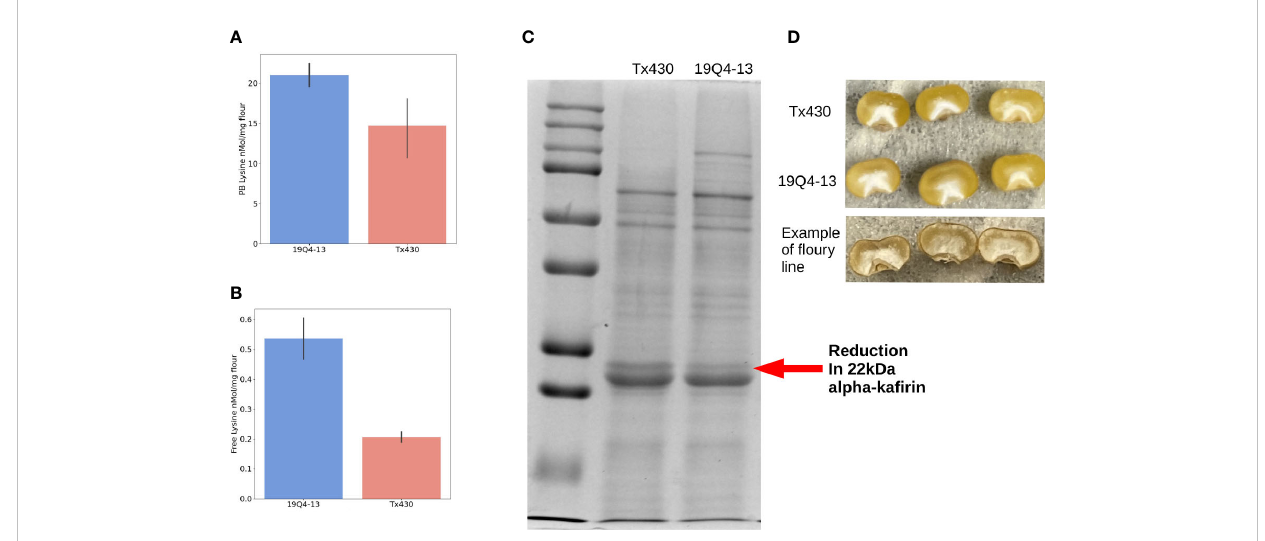
FIGURE 1 Protein phenotype of 19Q4-13. (A) 19Q4-13 displayed a 43% increase in protein-bound lysine content over wild-type Tx430 (p<0.05). (B) 19Q4-13 displayed a 161% increase in free lysine content over wild-type Tx430 (p<0.05). (C) The red arrow points to the 22kDa band, showing a reduction in the 22kDa alpha ka fi rin. (D) Edited line 19Q4-13 showed a similar level of kernel vitreousness to wild-type Tx430. An example of an edited sorghum line with a comparably less vitreous texture is shown